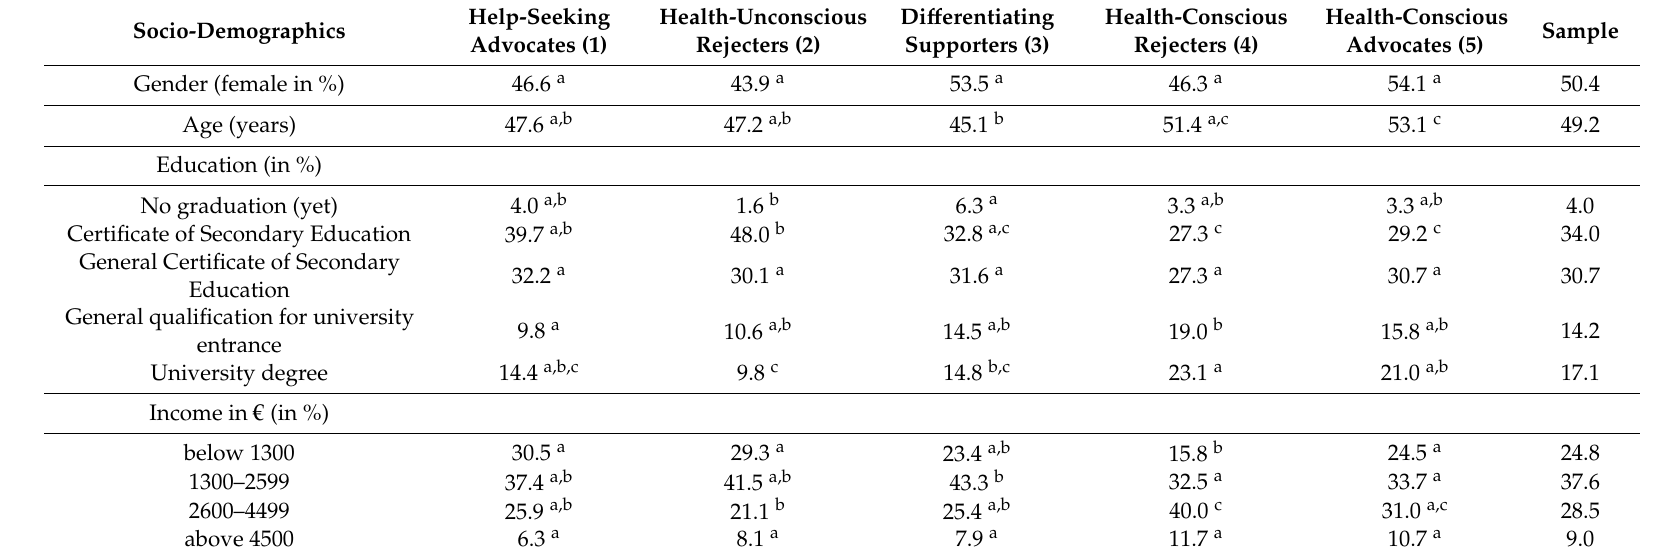
Table 6. Comparison of the sociodemographics of the